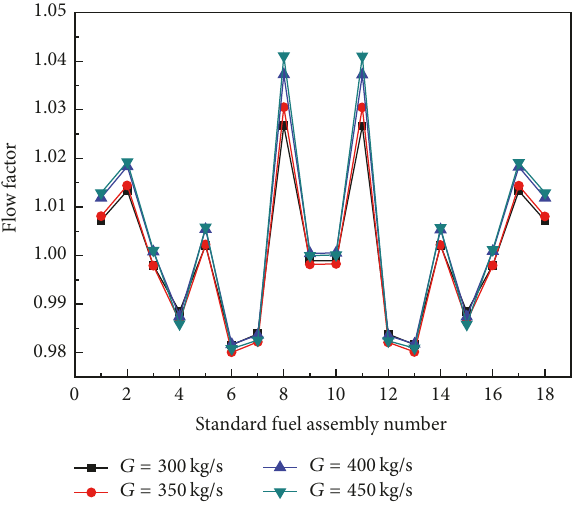
Figure 11: Variation of the flow distribution factor in each standard fuel assembly for various inlet flow rates.